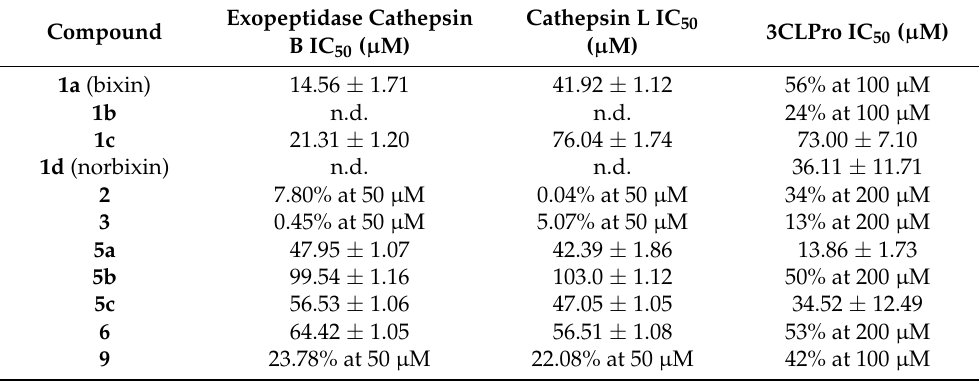
Table 2. Cathepsins B and L, and 3CLPro inhibitory effects of the glycopeptide conjugates and